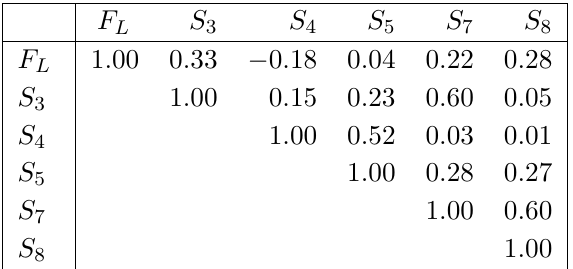
and S parameters obtained for q 2 2 L